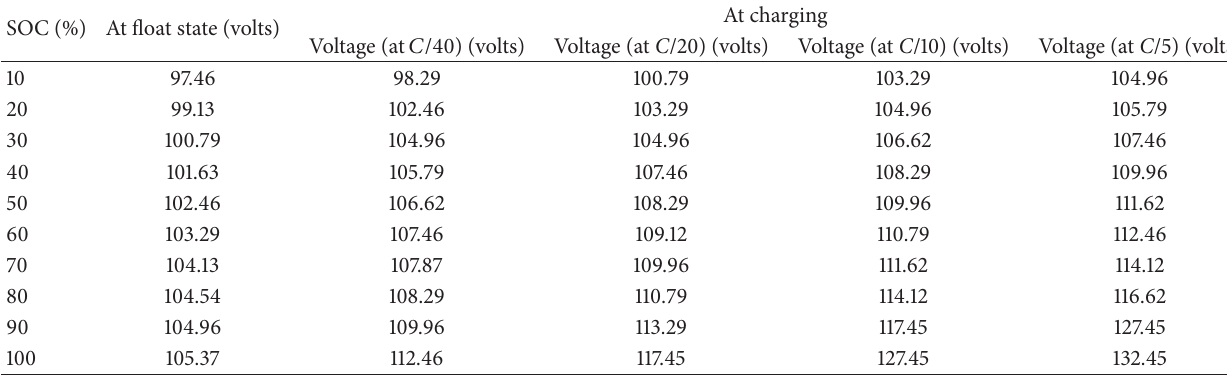
Table 1: SOC versus terminal voltage at various charging currents and at floating.